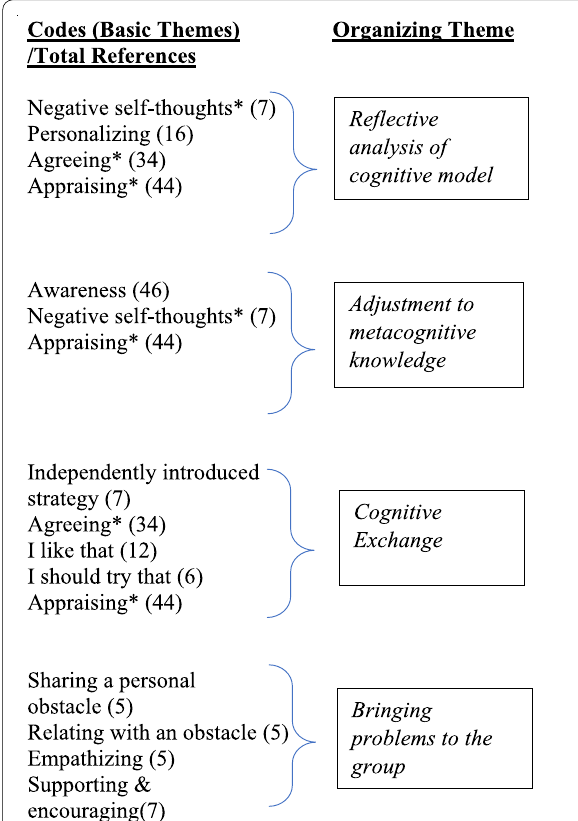
Fig. 3 Thematic analysis via Attride-Stirling. Basic themes were used to group student statements more broadly into organizing themes and again into global themes. The first column on the left provides the total number of references for basic themes while the third column provides references of those basic themes within specific organizing themes. (*The basic themes awareness, agreeing and negative self-thoughts occurred across more than one organizing